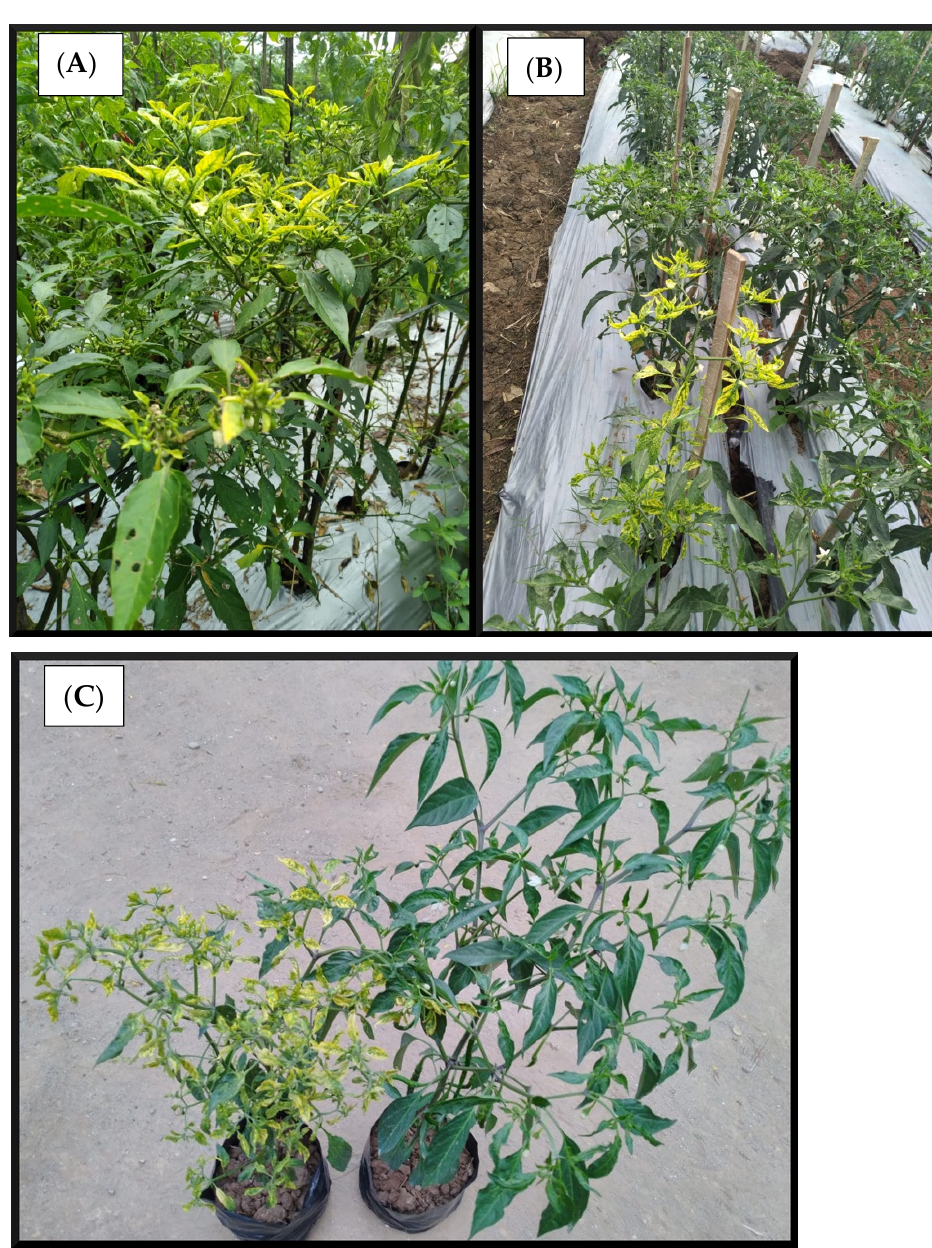
Figure 1. ( A ) Commercial chili plantation in Purworejo. ( B ) Commercial chili plantation in Cangkringan. ( C ) IPJ and UPJ samples. Table 1. Compounds emitted by pepper yellow leaf curl virus (PYLCV)-infected and PYLCV-undetected chili plants de- termined by gas chromatography-mass spectrometry (GC-MS).